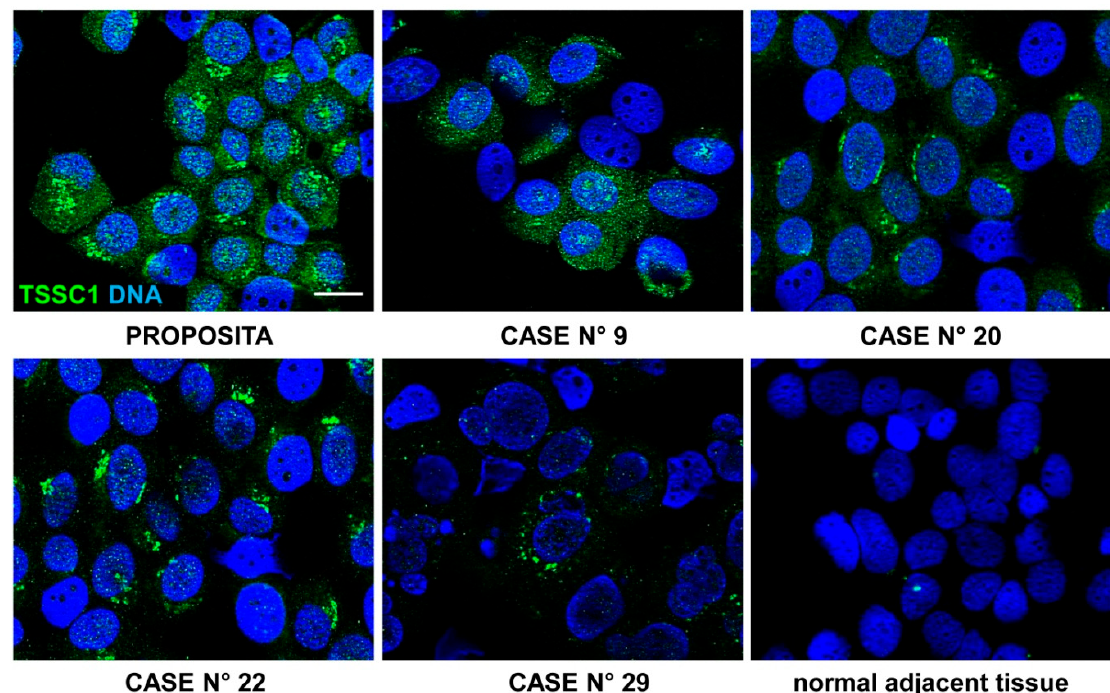
Figure 23. Expression of TSSC1 protein in stage 4 primary NB tissues. Immunofluorescence assay was performed using the anti-TSSC1 antibody (green). Images are representative of TSSC1 expression on the proposita tumor tissue (highly positive) and on other four stage 4 NB tissues among the 30 examined. Case number 29 showed a lower amount of TSSC1 positive cells. Normal adjacent tissue displayed very low expression of TSSC1. Cells were counterstained with DAPI to visualize nuclei (blue). (Scale bar: 10 μ m). Table 25. Diagnostic characteristics of stage 4 NB patients whose tumors were analyzed by immunofluorescence for TSSC1. Age Case N ◦